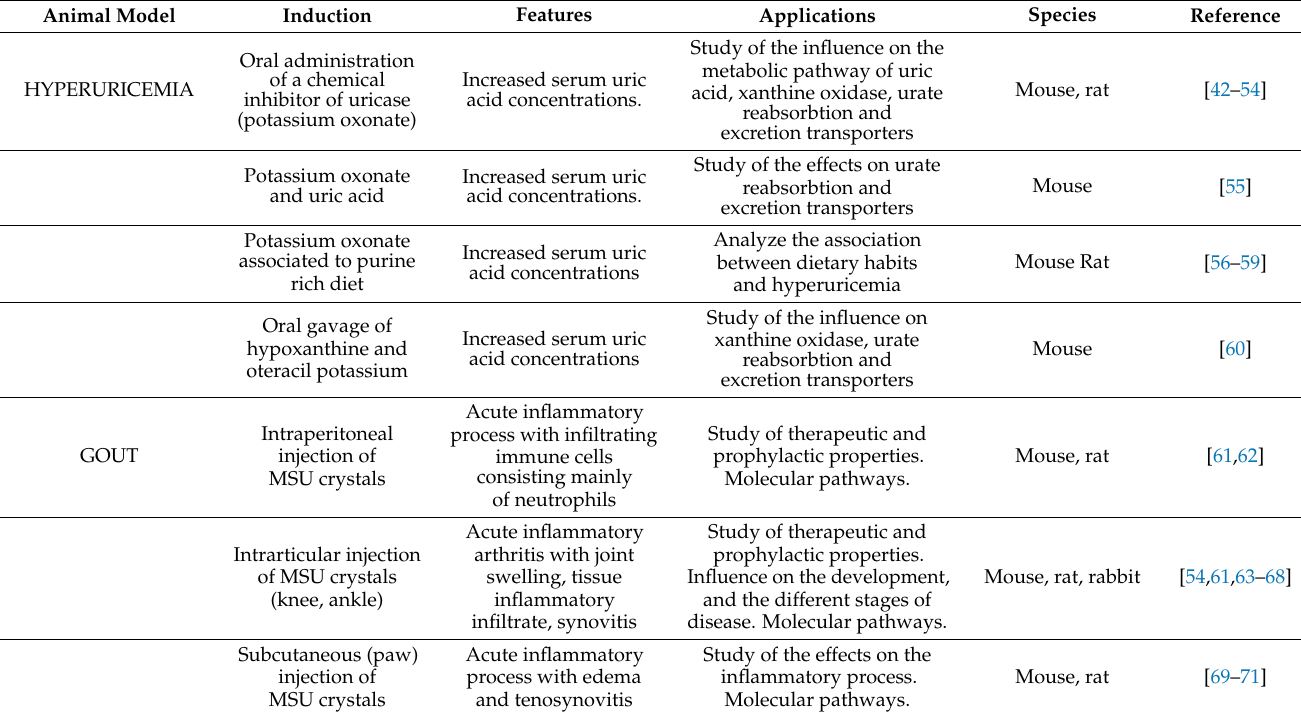
Table 1. Principal induced animal models of disease in the study of bioactive compounds in gout and